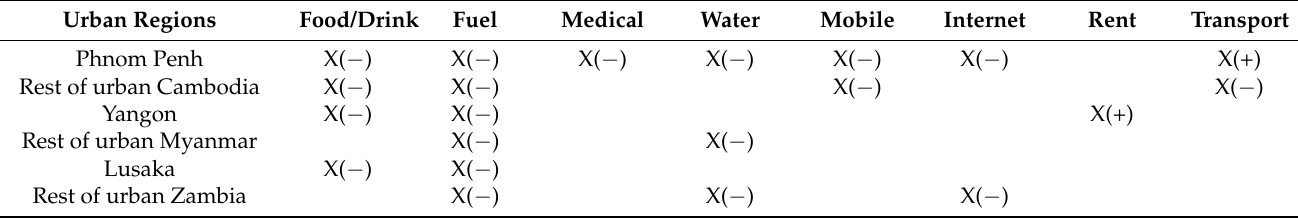
Table 9. Monthly expenditure items with a statistically significance difference between modern fuel-intensive and modern fuel exclusive households (X = significant, +/ − = increase/decrease in expenditure).